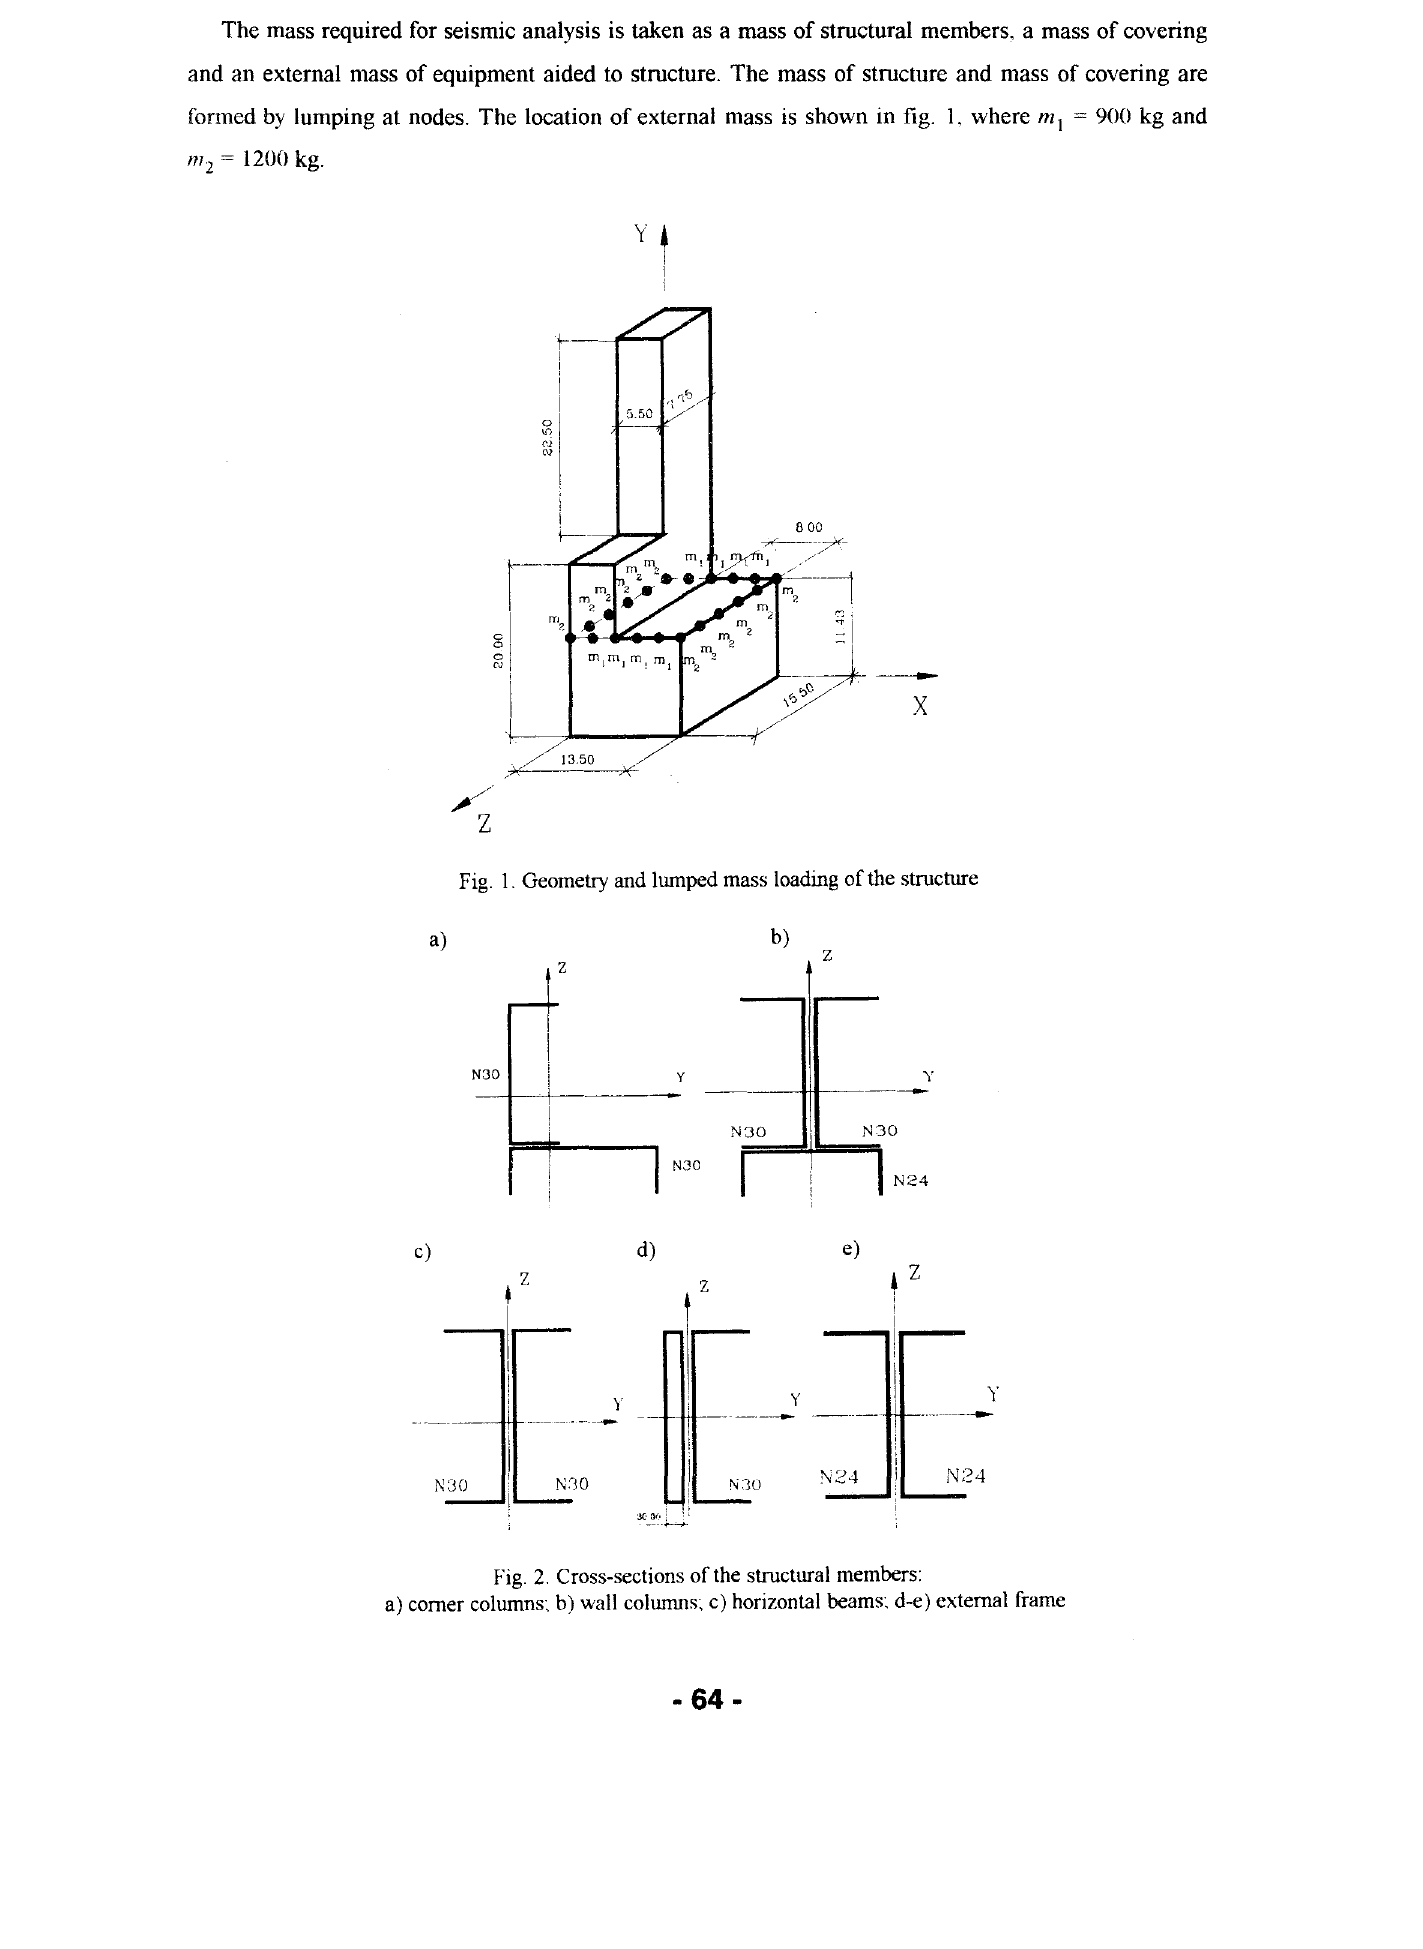
Fig. 2. Cross-sections of the structural members: